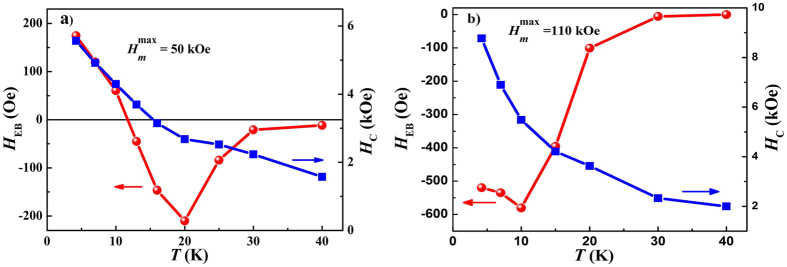
Temperature dependence of HEB and HC with  = 50 kOe (a) and 110 kOe (b) after ZFC.